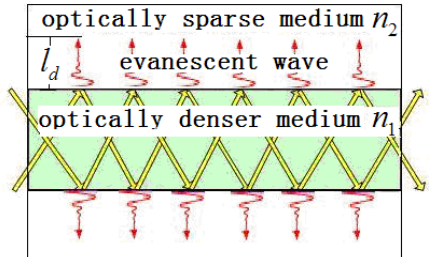
Figure 1. Penetration depth. The evanescent field decays in value of 1/e on the fiber